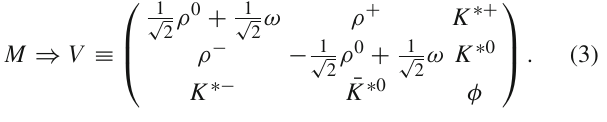
Table 1 Weights h (cid:8) ( ¯ h (cid:8) ) of the different I = 1, G = − 1, V P compo- i i nents for the M 0 ( N i ) amplitudes ρ 0 π